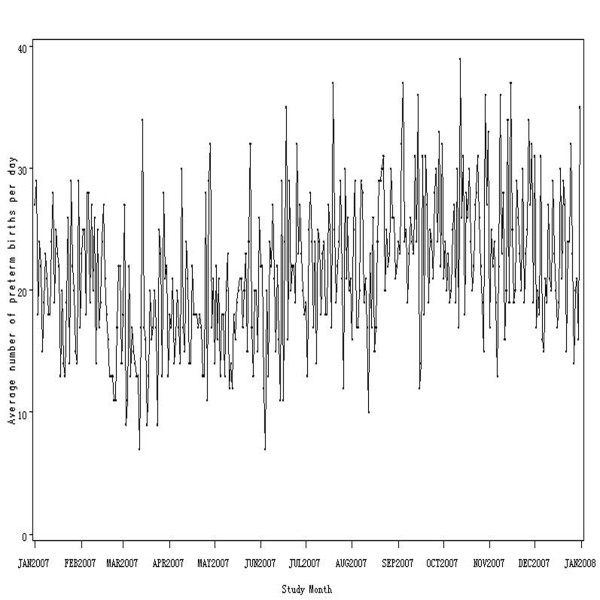
Average number of preterm births per day by study month in Guangzhou, China in 2007.